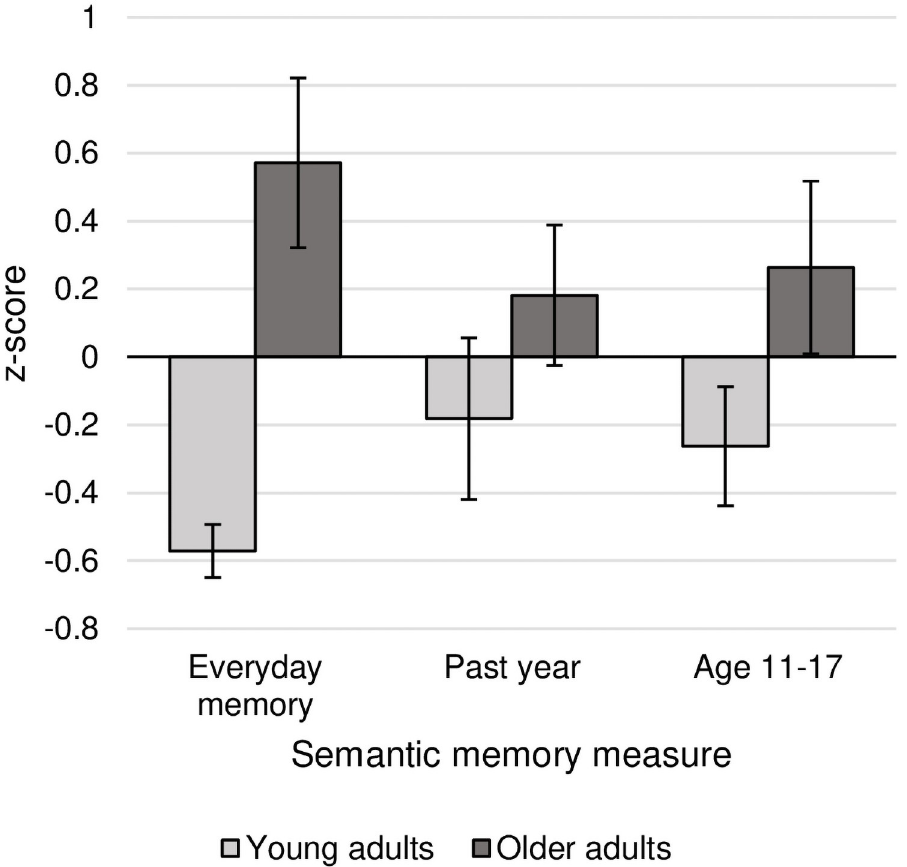
Fig 2. Older and younger adults’ semantic memory scores plotted as z-scores. Error bars represent standard error.